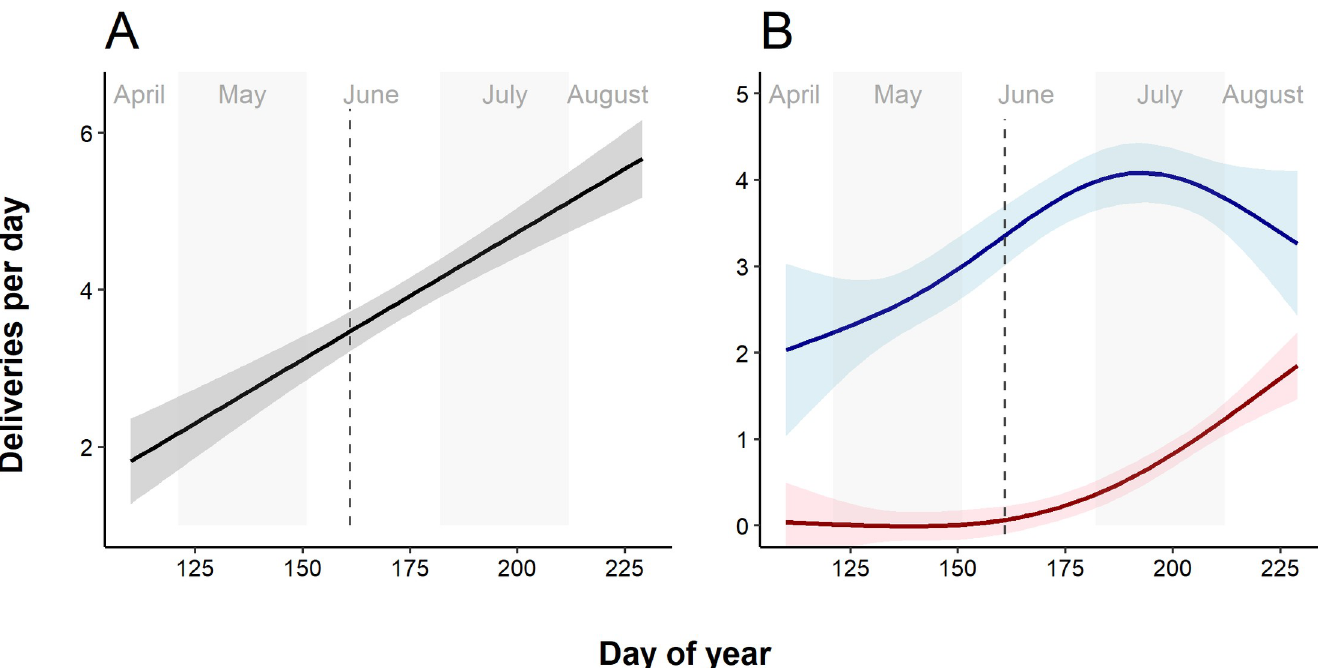
Fig 2. General additive models indicating temporal changes in prey deliveries in total (A) and in male (blue) and female (red) parents (B). 95% confidence intervals are shaded. Hatching time is indicated by a dashed vertical